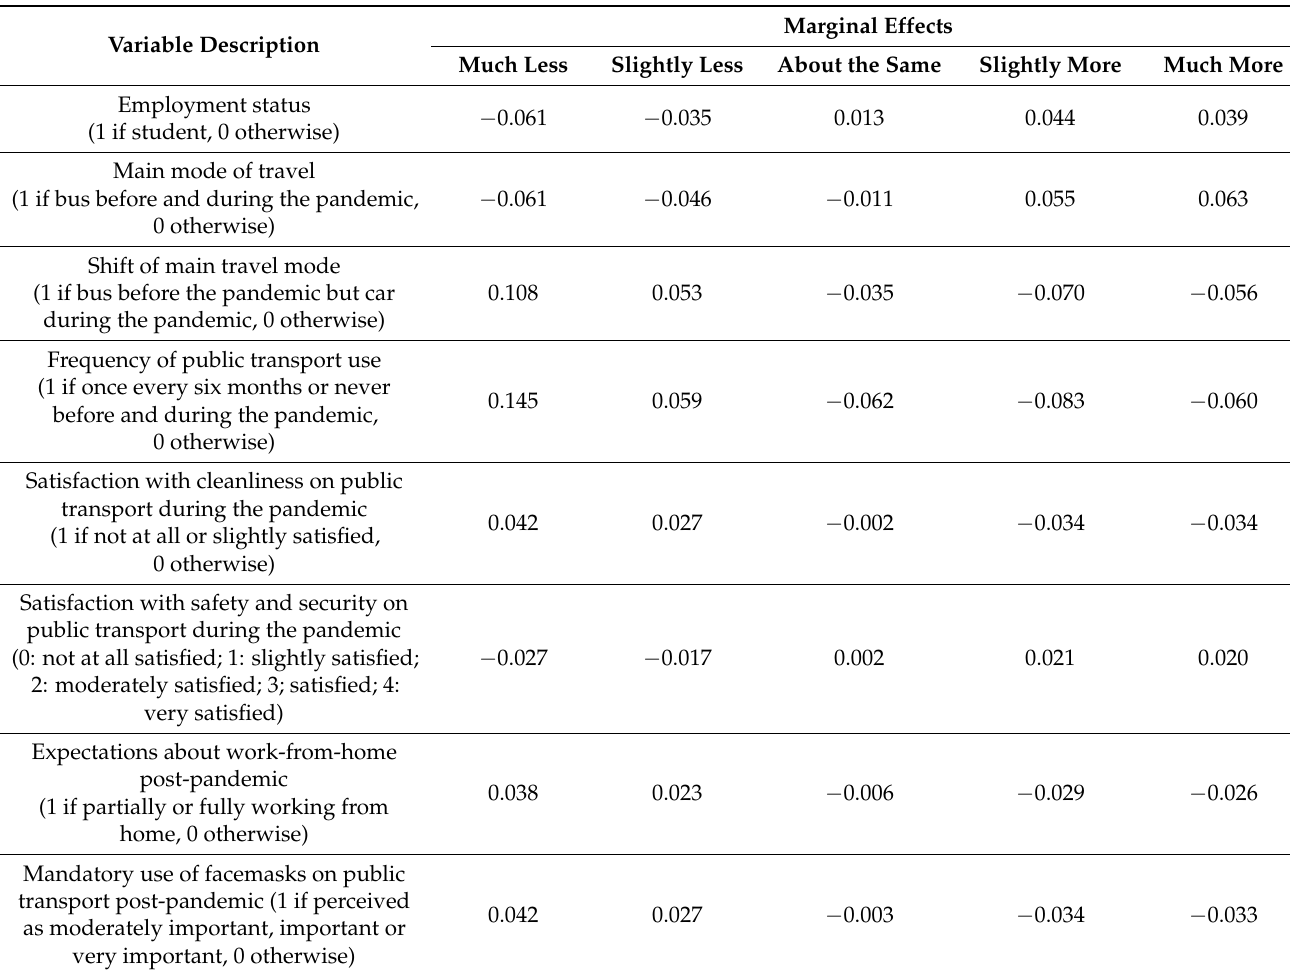
Table 3. Marginal effects of the variables included in the model for expectations about the use of public transport in the